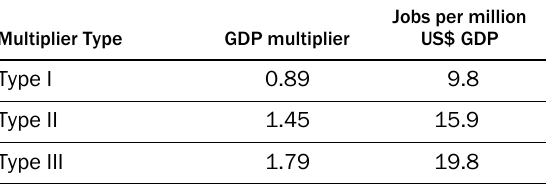
Table 3. Multipliers for SNAP’s Impact